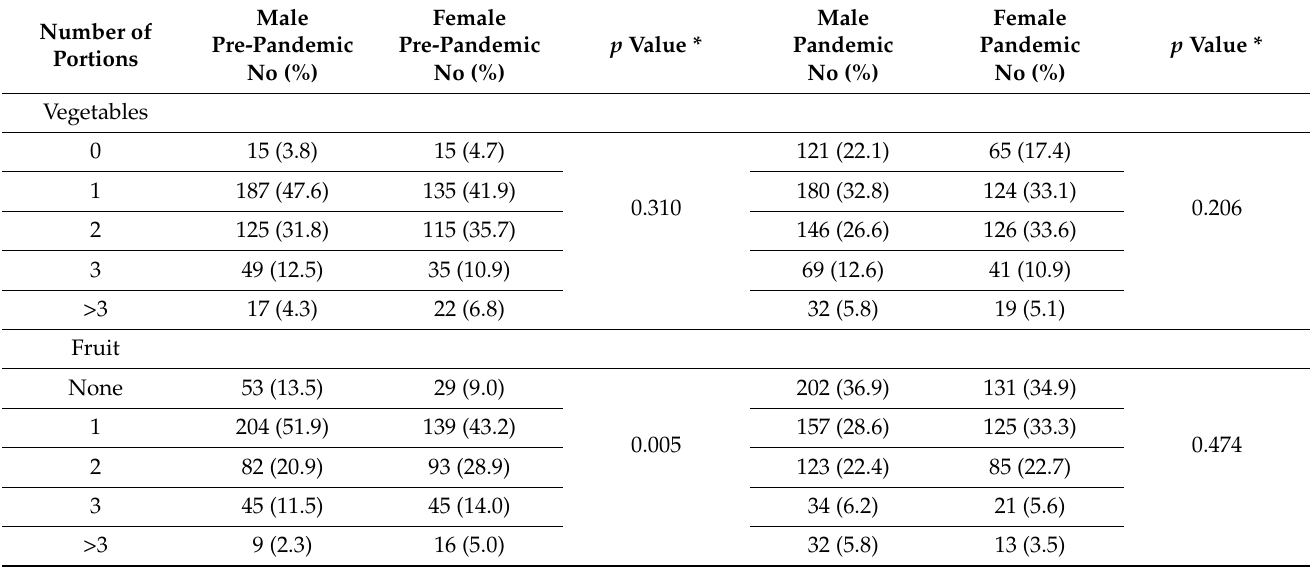
Table 5. The frequency of fast-food consumption per week.